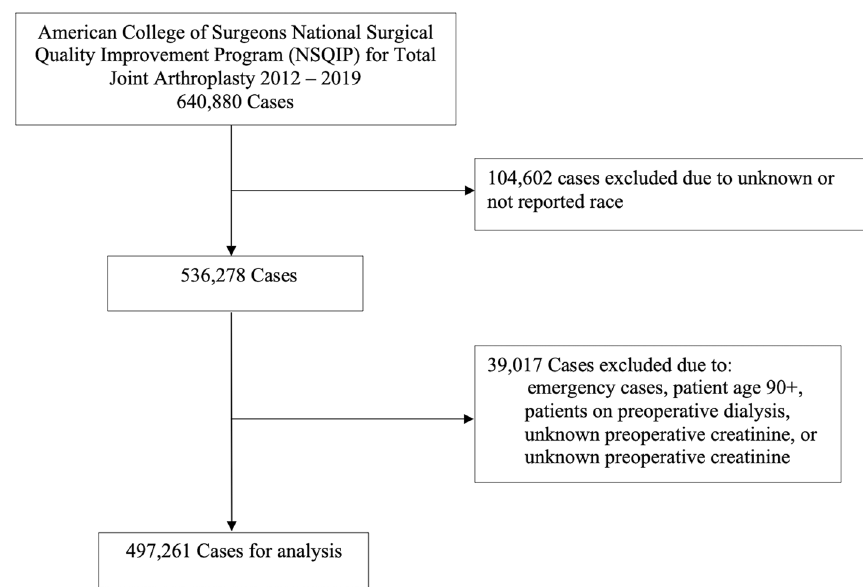
Fig. 1 Flow diagram indicating study inclusion and exclusion